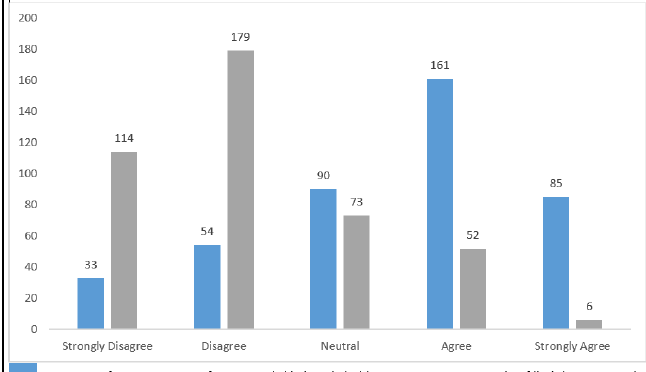
Figure 2 Perception of Unfilled Requests: Print vs